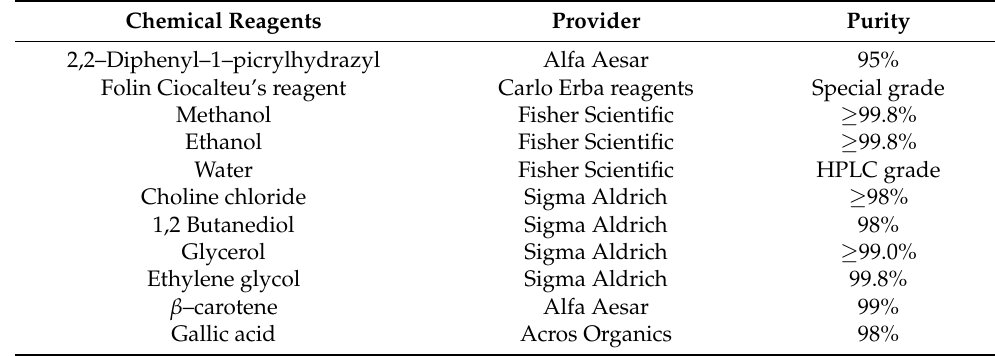
Table 6. Chemical reagents.